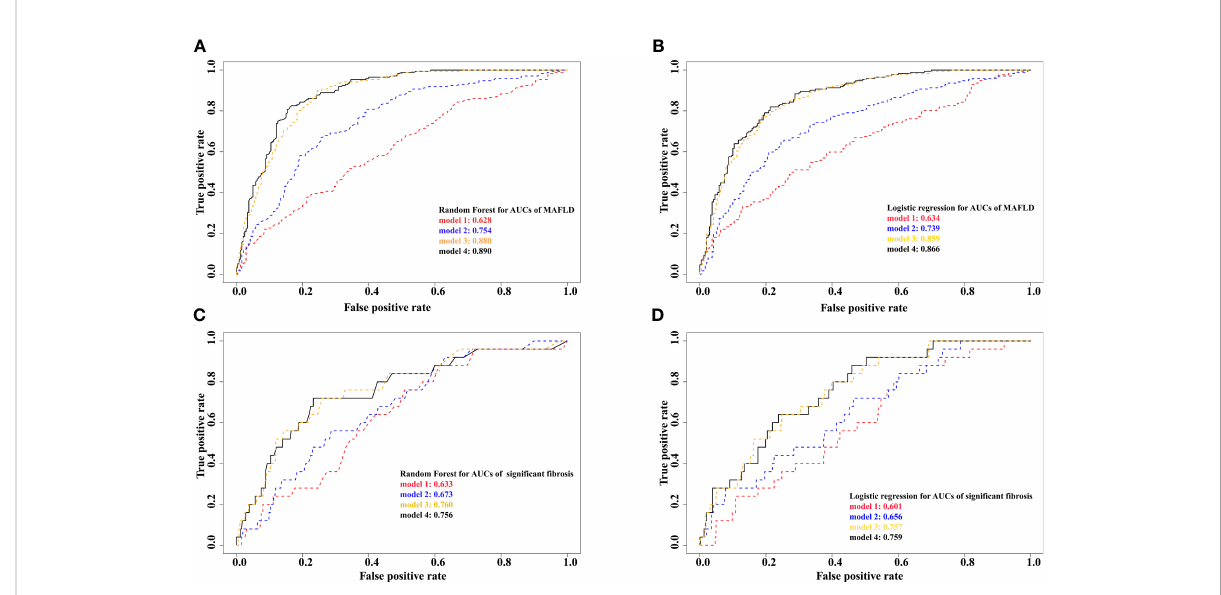
FIGURE 5 Prediction results from different models for MAFLD and signi fi cant fi brosis (A) , random forest for MAFLD. (B) , logistic regression for MAFLD. (C) , random forest for signi fi cant fi brosis. (D) , logistic regression for signi fi cant fi brosis. Model 1 adjusted for age, race, education, poverty, married status, smoking, alcohol use, HEI, physical activity, hypertension. Model 2 further adjusted for total cholesterol, alanine aminotransferase, and aspartate transaminase. Model 3 further adjusted for BMI, waist circumference, and fat mass index. Model 4 further adjusted for appendicular and trunk skeletal muscle mass index. MAFLD, metabolic dysfunction-associated fatty liver